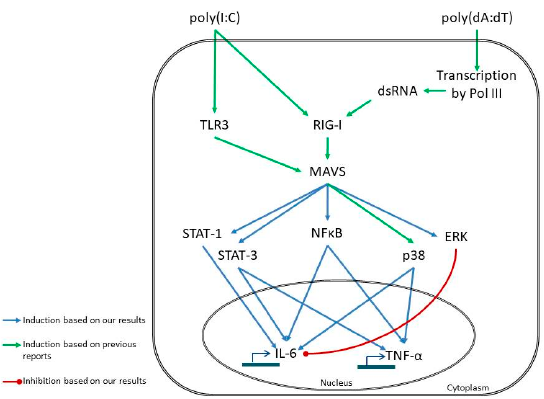
Figure 4. Proposed model of poly(I:C)- and poly(dA:dT)-induced signaling events leading to IL-6 and TNF- α expression in keratinocytes, based on our results and results of previous reports [21–23,44]. Our results indicate that poly(I:C) and poly(dA:dT) induce the same inflammatory pathways; however, the mode of sensing differs, leading to the observed differences in kinetic. The receptors for poly(I:C) sensing are toll-like receptor 3 (TLR3) [21] and retinoic acid induced gene I (RIG-I) [22]. In contrast, poly(dA:dT) is transcribed to double-stranded (ds) RNA by RNA polymerase III (Pol III) and is subsequently sensed by RIG-I [23]. The transcription step might be responsible for the delayed response to poly(dA:dT). The receptors activate the NF- κ B, MAPK and STAT signaling routes through the adaptor molecule mitochondrial antiviral signaling protein (MAVS), and, thus, regulate the transcription of the